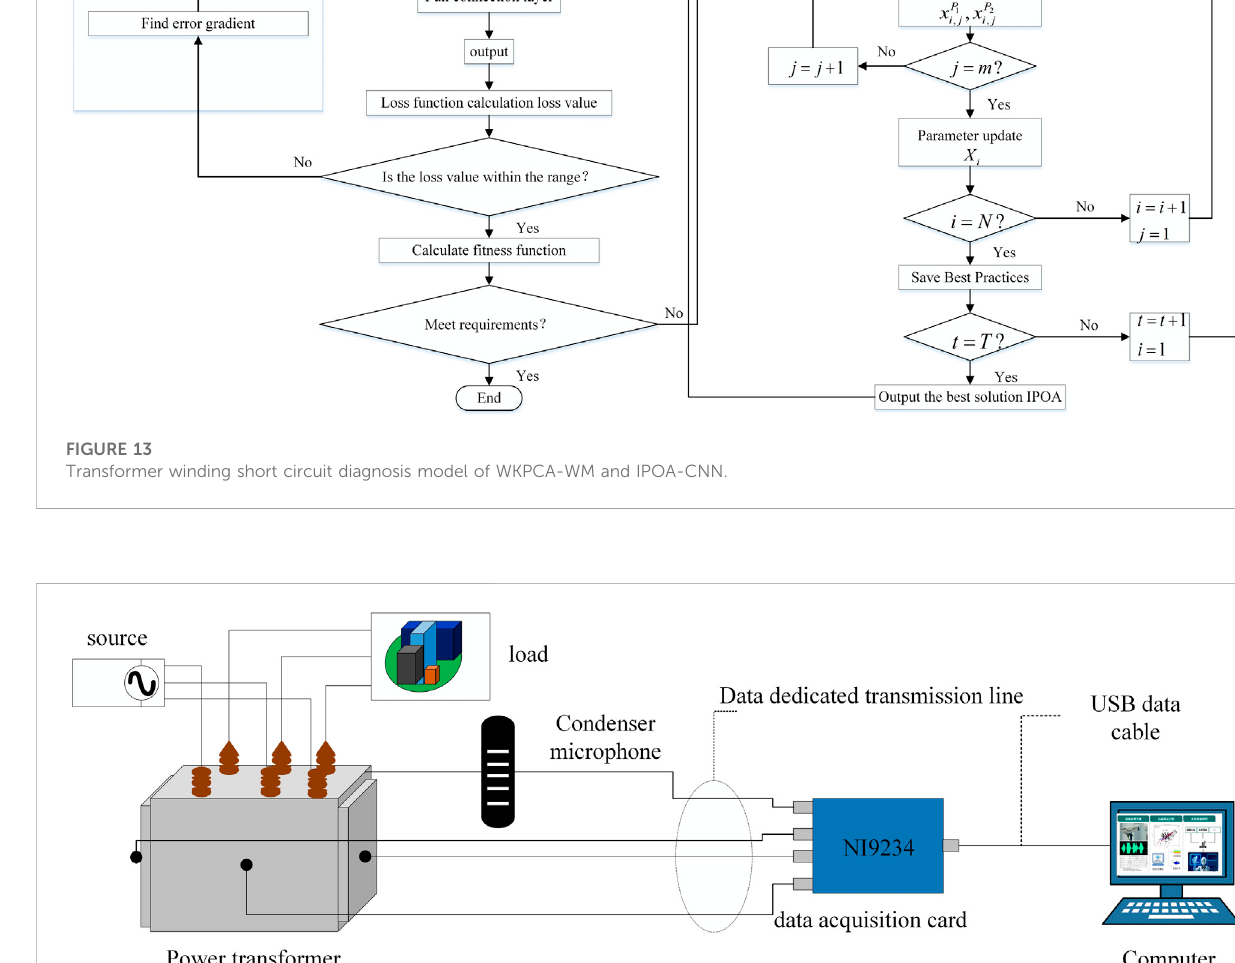
FIGURE 14 Transformer acoustic signal acquisition experimental platform.